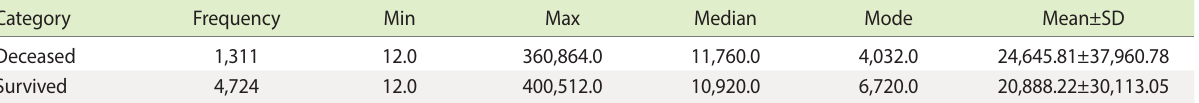
Table 4. Distribution of cumulative exposure time (hour) to humidifier disinfectants 1 Category